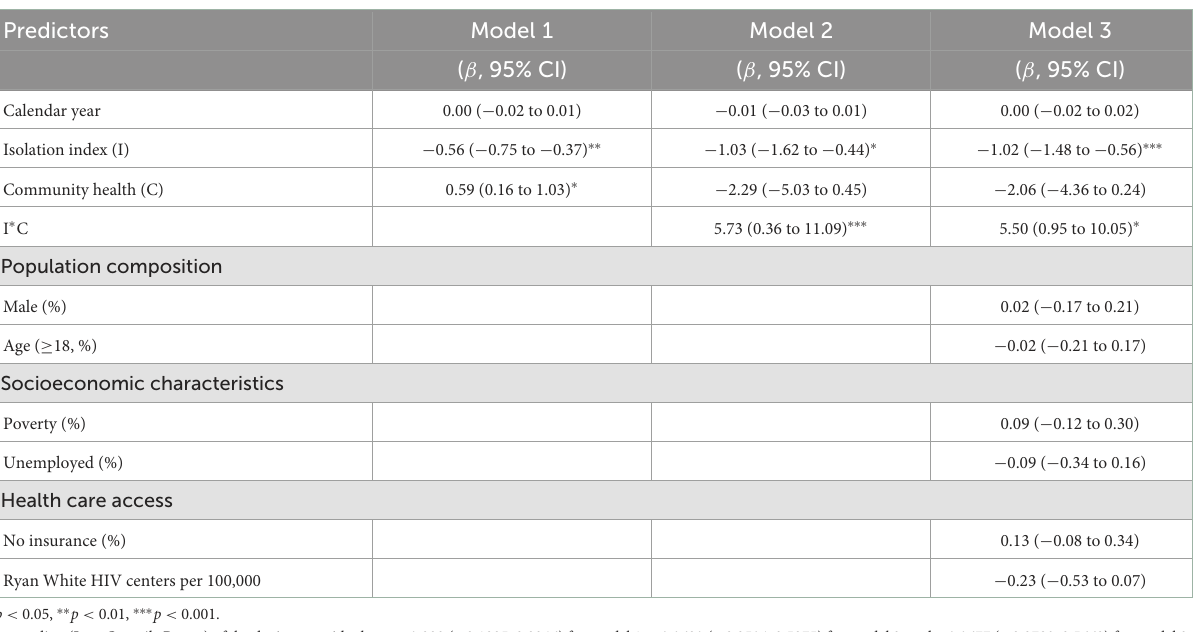
health within each county. Last, Individuals without viral load records were excluded from calculating the viral suppression rate in that year. The missing measurement of viral load might indirectly reflect dropping out of care or other reasons, such